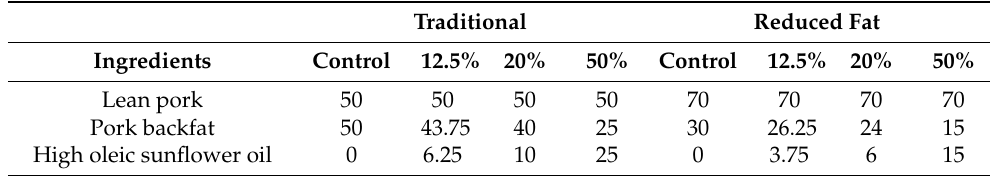
Table 1. Dry fermented sausage formulations with backfat replacement with high oleic sunflower oil as a percentage of total weight. Control: 0% replacement; 2.50% = 12.50% replacement; 20% = 20% replacement; 50% = 50%